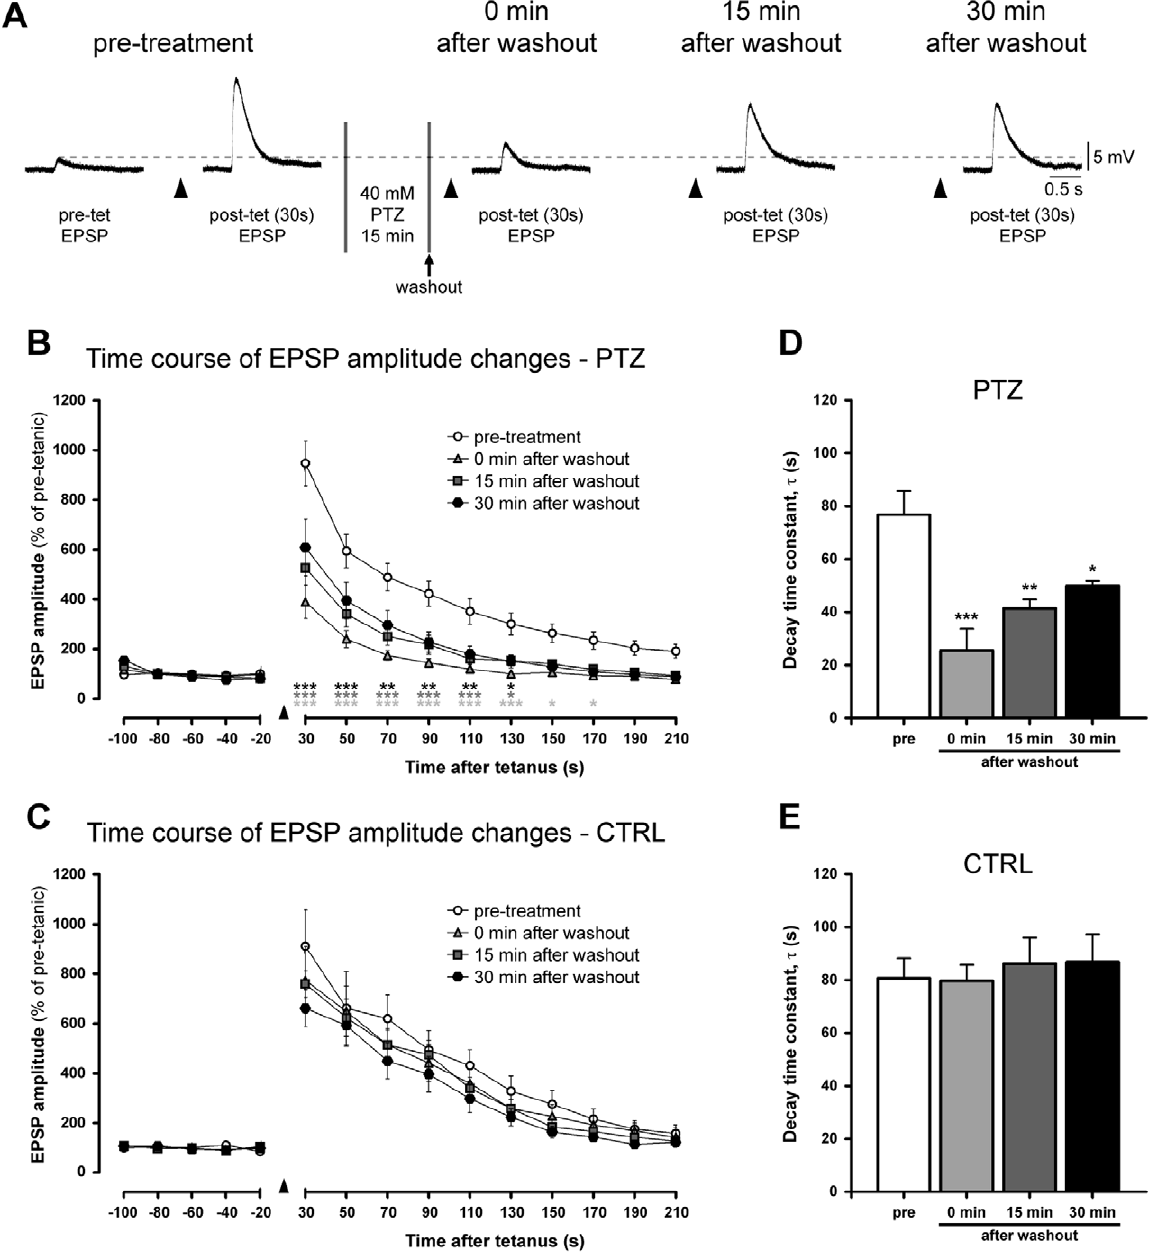
Figure 5. Epileptiform activity impairs PTP induction and decay. (A) Sample electrophysiological recordings of the first post-tetanic EPSPs evoked 30 seconds after the tetanic stimulation (arrowhead) at B2–B2 synapses. Dashed line indicates the amplitude of the pre-treatment EPSP evoked before tetanisation. PTP was tested before (pre-treatment) and after 40 mM PTZ treatment at different time-points (0, 15 and 30 minutes after washout). (B,C) The time course of EPSP amplitude changes in PTZ-treated and control synapses. Values are normalized to the average amplitude of the last five pre-tetanic EPSPs. A strong impairment in PTP amplitude and decay was detected only in the treated group. (D) Bar graph of the PTP decay time constants measured in treated B2–B2 synapses showing a large reduction in t . (E) Conversely, values in control group were similar at all time-points.